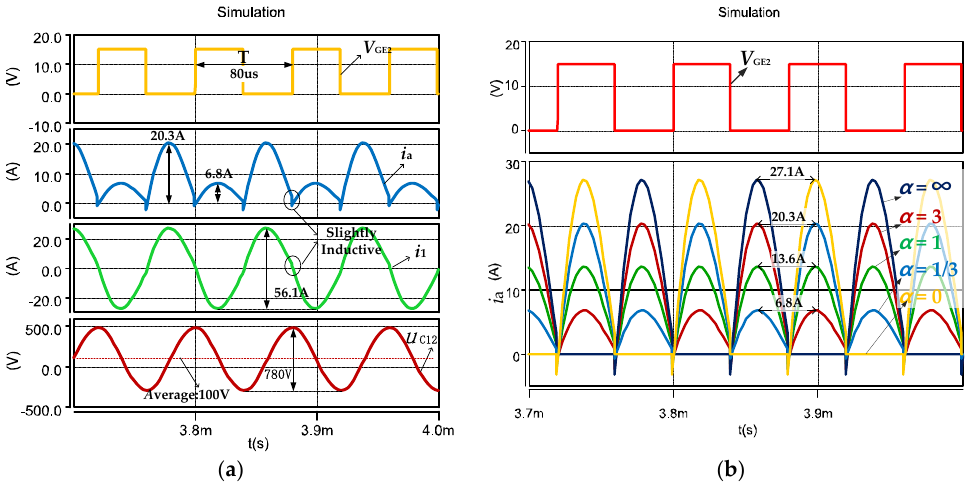
Figure 10. Simulation results: ( a ) Simulation waveforms of α = 3 ( V GE2 , bus current, primary coil current, capacitor voltage); ( b ) Waveforms of i a for different α.